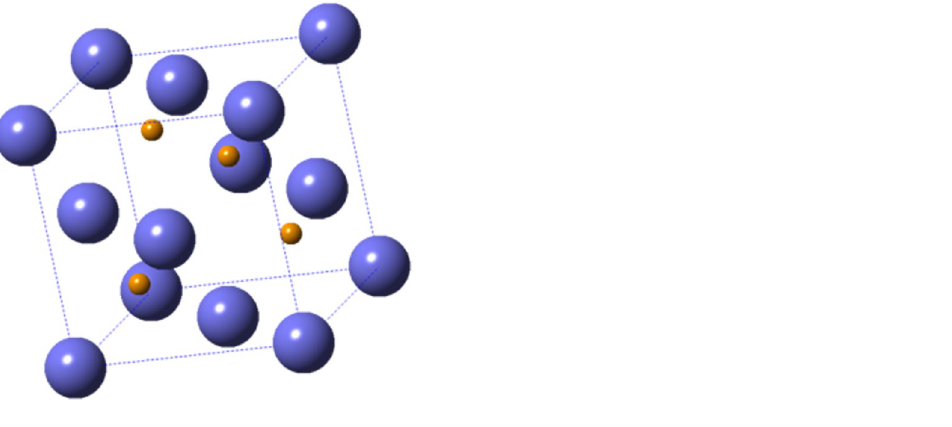
Figure 2. F m 43 where a = 0.599 nm and Cu is spatially distributed in octahedral interstitial